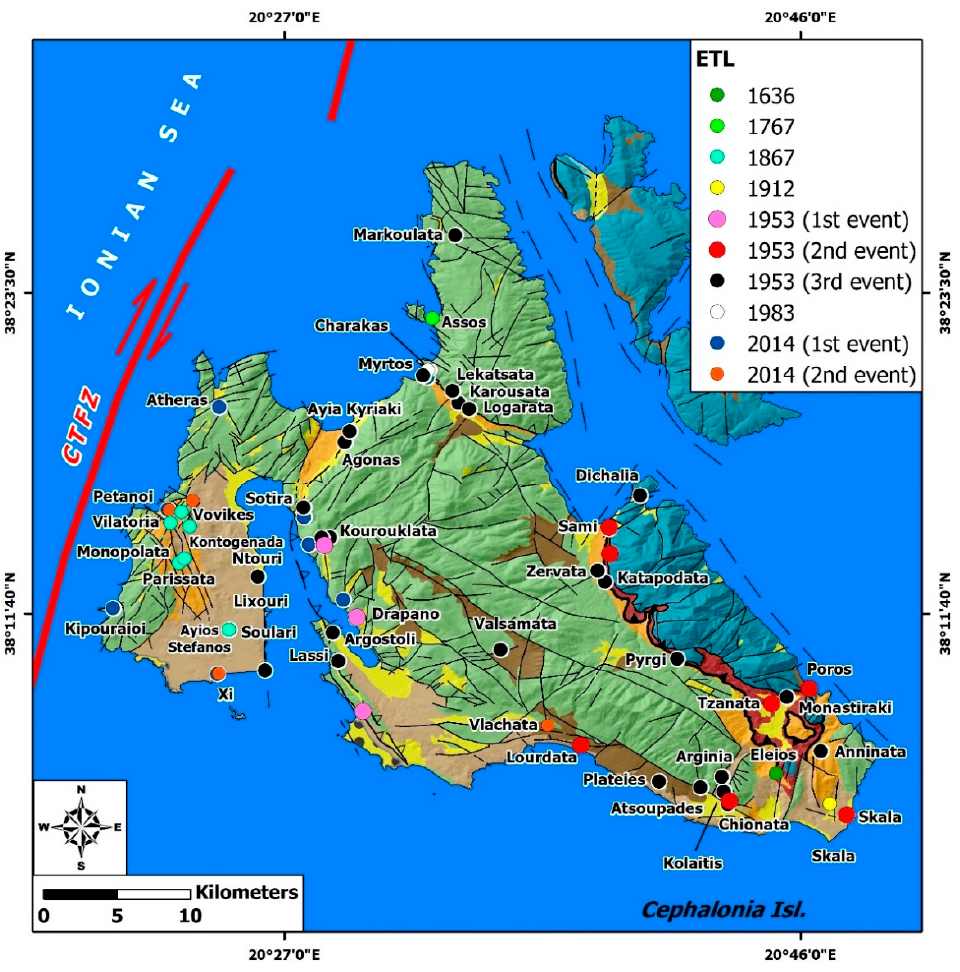
Figure 4. The neotectonic map of Cephalonia along with the historical and recent ETL in the island. Legend of the geological formations in Figure